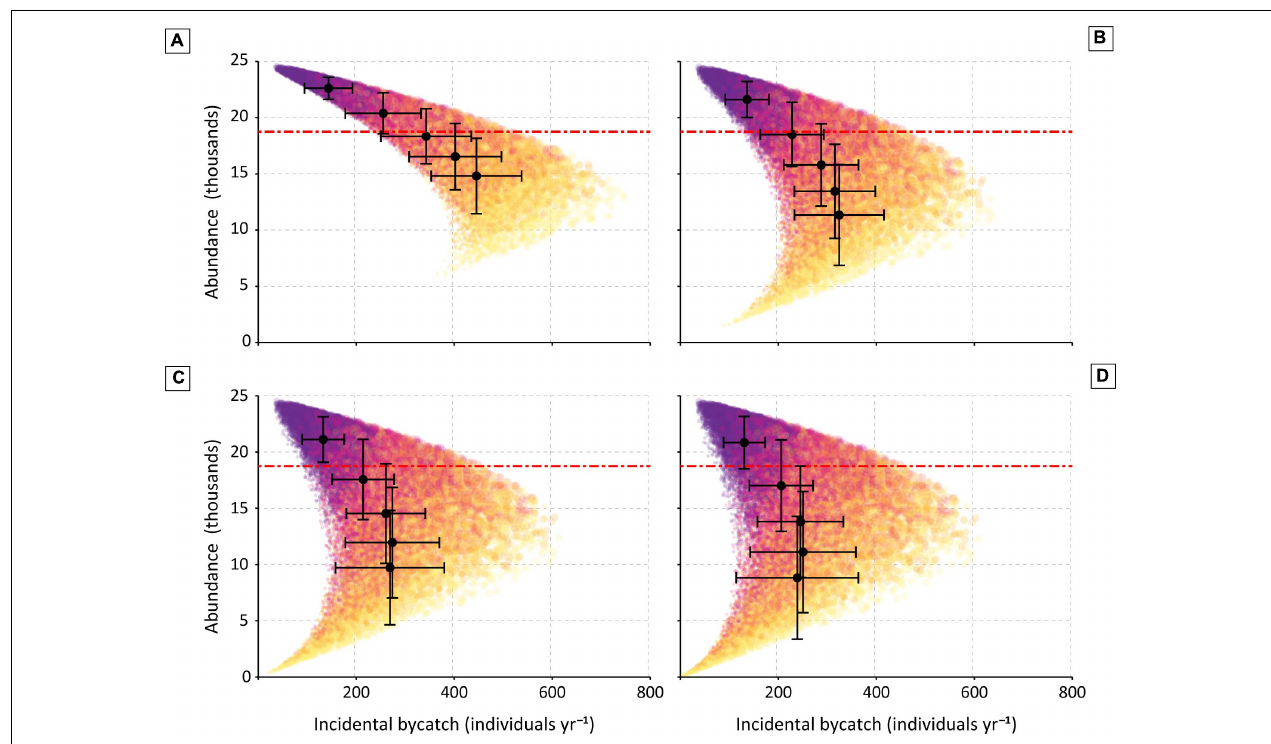
FIGURE 4 | Dispersion plots of abundance against annual bycatch rate; (A) 25 years, (B) 50 years; (C) 75 years; (D) 100 years; dot size: r = {0.04, 0.07, 0.1}; color indicates c (cid:48) : purple = 1, violet = 2, red = 3, orange = 4, yellow = 5; red dotted line: critical ecological threshold; black dots and lines indicate the mean and confidence intervals for c (cid:48) = {1,2,3,4,5} , respectively.